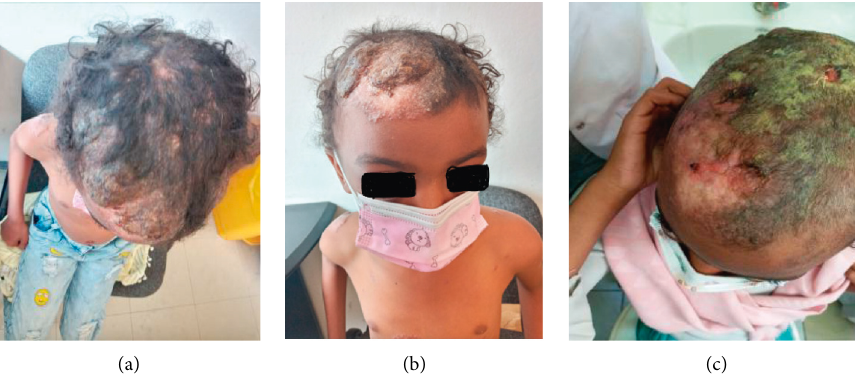
Figure 5: (a),(b) Diffuse yellowish-crusted plaque with associated hair loss on the anterior scalp area at 11 years and 3 months (5c) healing scalp lesion after antibiotic and anti TB treatment at the age of 11 years and 6 months.